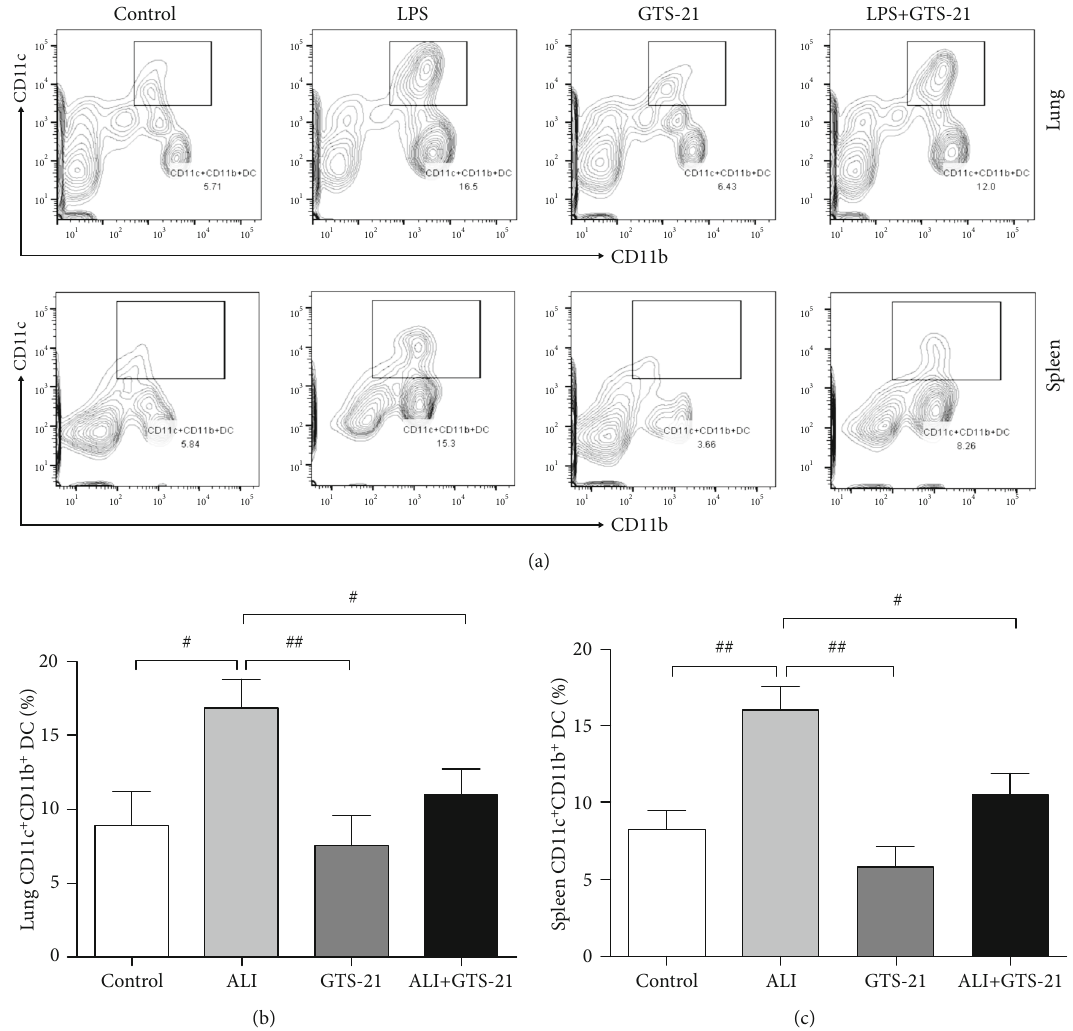
Figure 3: GTS-21 treatment reduced the number of cDCs2 in the lungs and spleens of sepsis-induced ALI mice. (a) Flow cytometry analysis was used to examine the CD11c + CD11b + cDCs2 isolated from the lung and spleen MNCs of mice. (b, c) The relative percentages of lung and spleen CD11c + CD11b + cells in di ff erent groups. n = 4 – 6 mice/group. All data are shown as mean ± SD . # p < 0 : 05 , ## p < 0 : 01 , ### p < 0 : 001